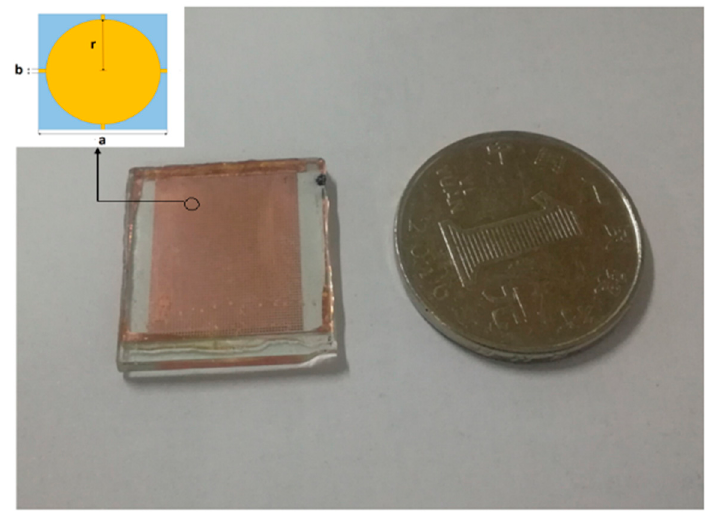
Figure 4. Fabricated metamaterial absorber.